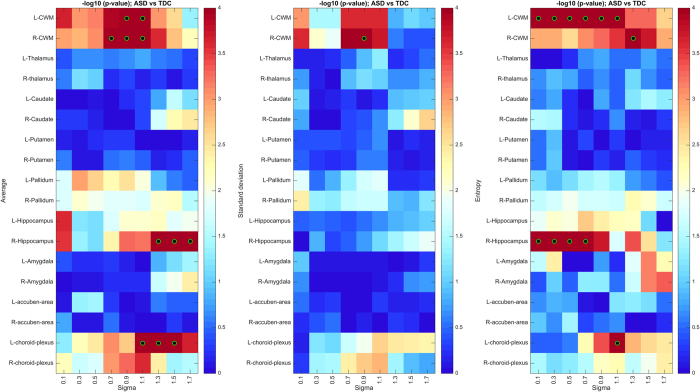
Significance of ASD vs TDC (uncorrected p-values, −log10 scale) in selected regions, for various filter scales (sigma).Green-black circles indicate region-scale values with significant p-values following Holm-Bonferroni correction.